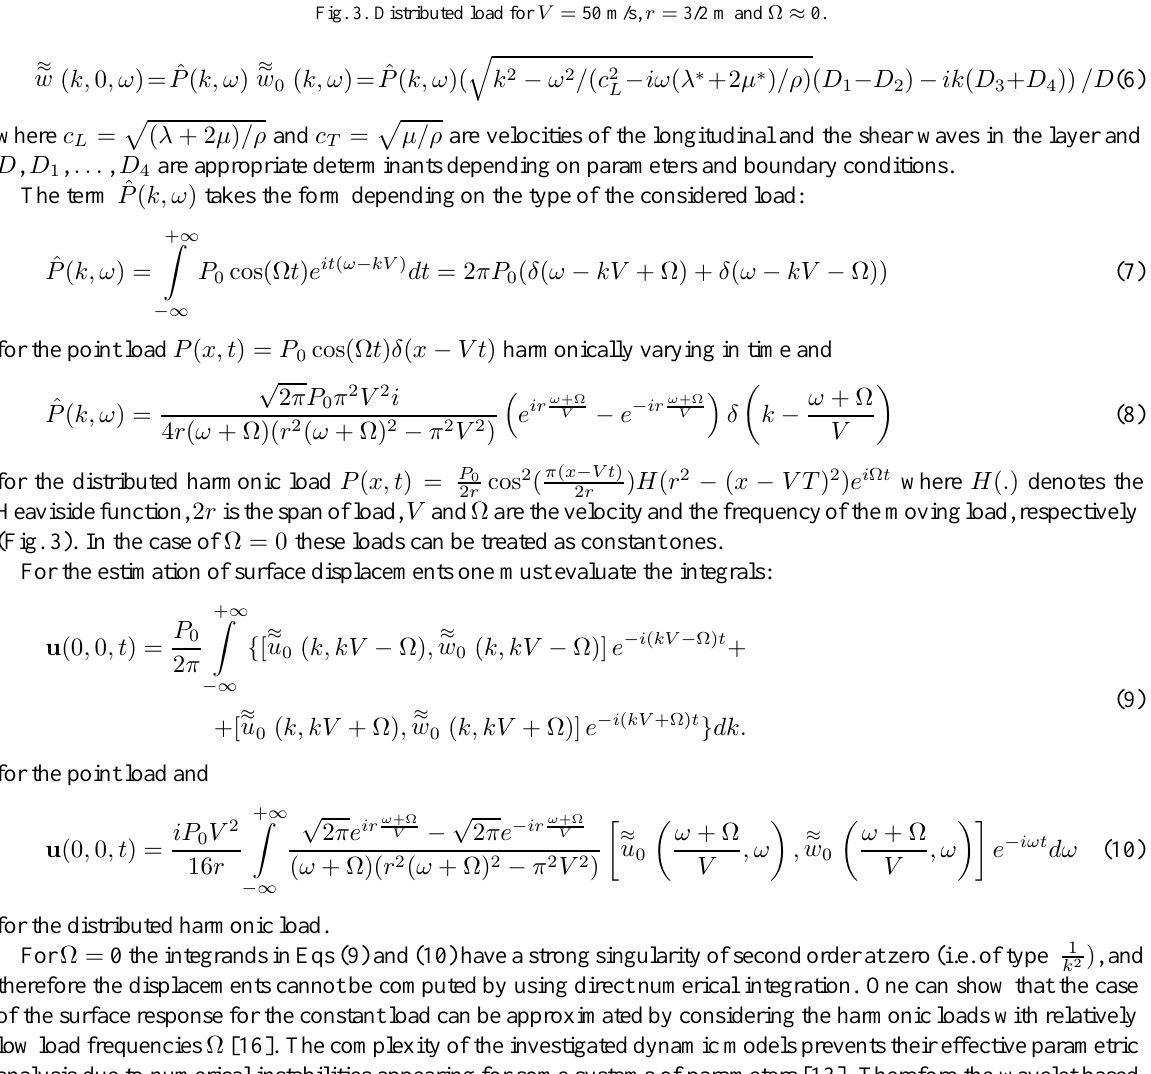
≈ w ( k, 0 , ω )= ˆ P ( k, ω ) ≈ w